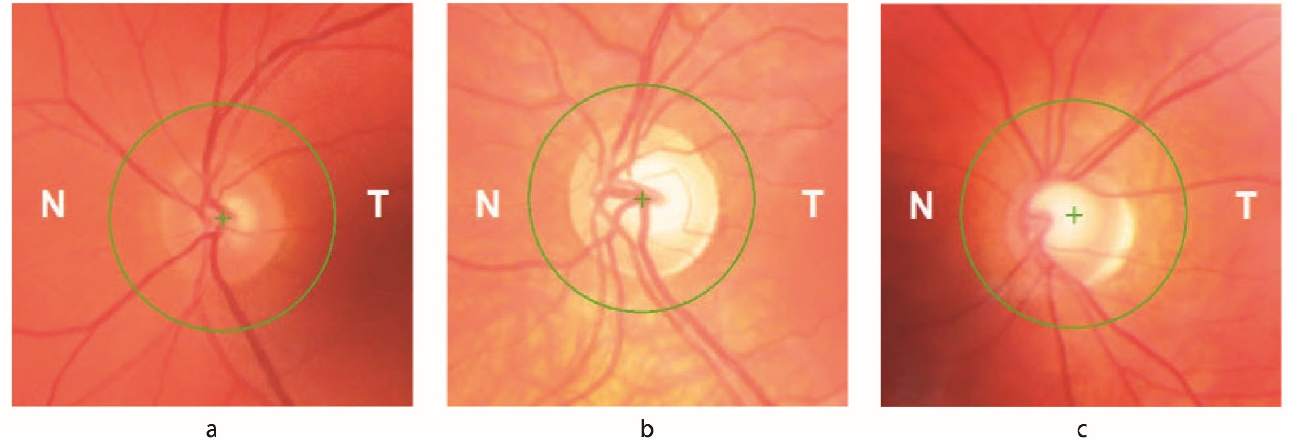
Figure 1. Retinal fundus images with circular volume scan delineation of FRDA patients with varying degrees of optic neuropathy. ( a ) Normal appearance of the optic disc (patient 33); ( b ) Optic disc pallor in a patient with normal visual acuity (patient 2); ( c ) Diffuse optic disc pallor in a patient with reduced visual acuity (patient 21). N Nasal; T Temporal.